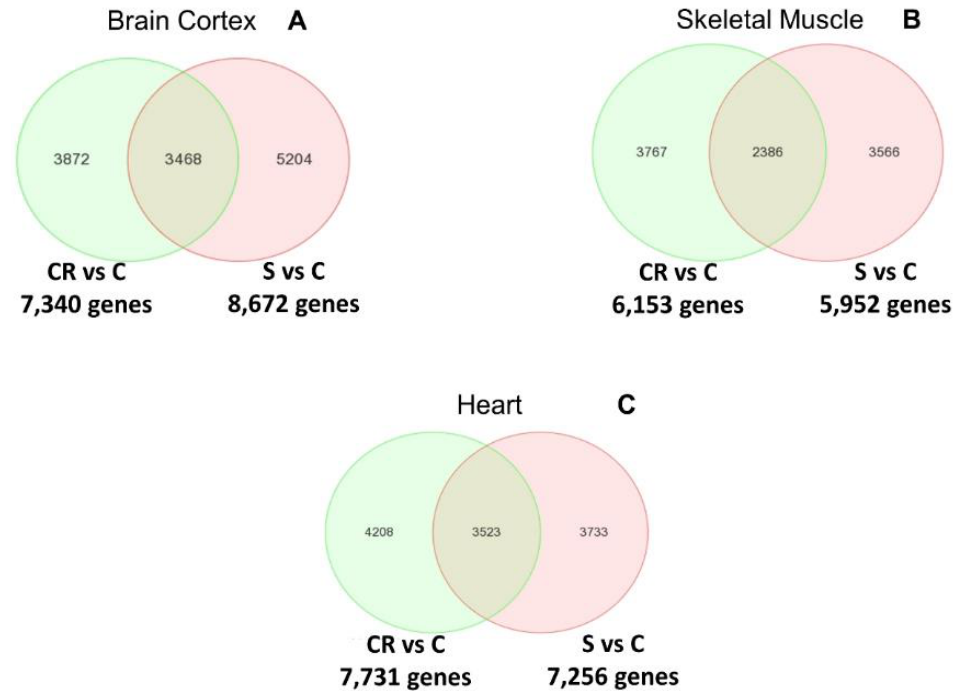
Figure 2. Venn diagrams of the differentially expressed genes that overlap between old calorie restricted (CR) vs. (C) and old supplemented with a calorie restriction mimetic (S) vs. old mice (C) in brain cortex (Panel A), skeletal muscle (Panel B) and heart (Panel C). Panel A indicates the differentially expressed genes between both comparisons in brain cortex: CR vs. old controls (CR vs. C) and supplemented vs. old controls (S vs. C). The Venn diagram in panel A indicates that more than 3400 genes overlap. The complete list of genes can be consulted in the